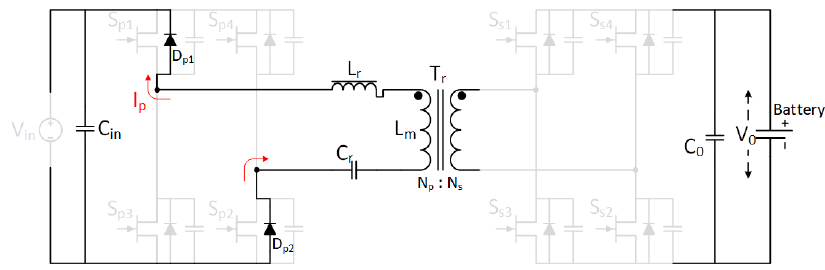
Figure A1. LLC resonant converter topology interval-1.